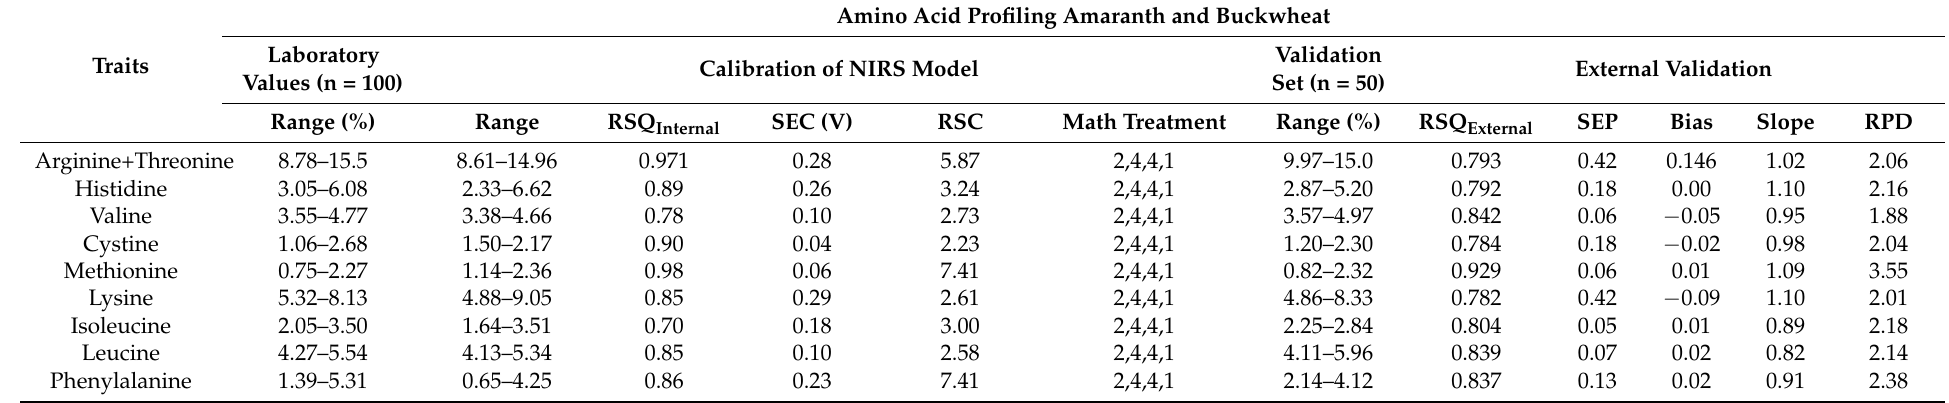
Table 3. Statistics for essential amino acids of combined samples of amaranth and buckwheat used in calibration and